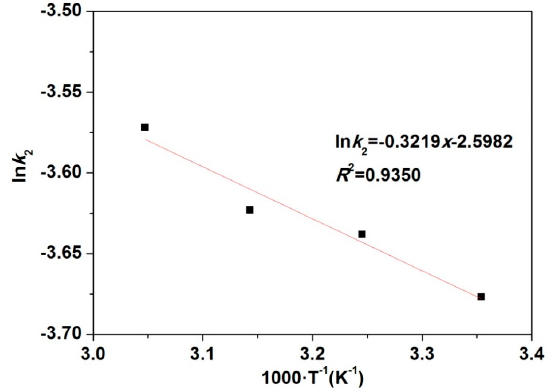
Figure 8. Arrhenius plot for iron adsorption by Rexp-501.